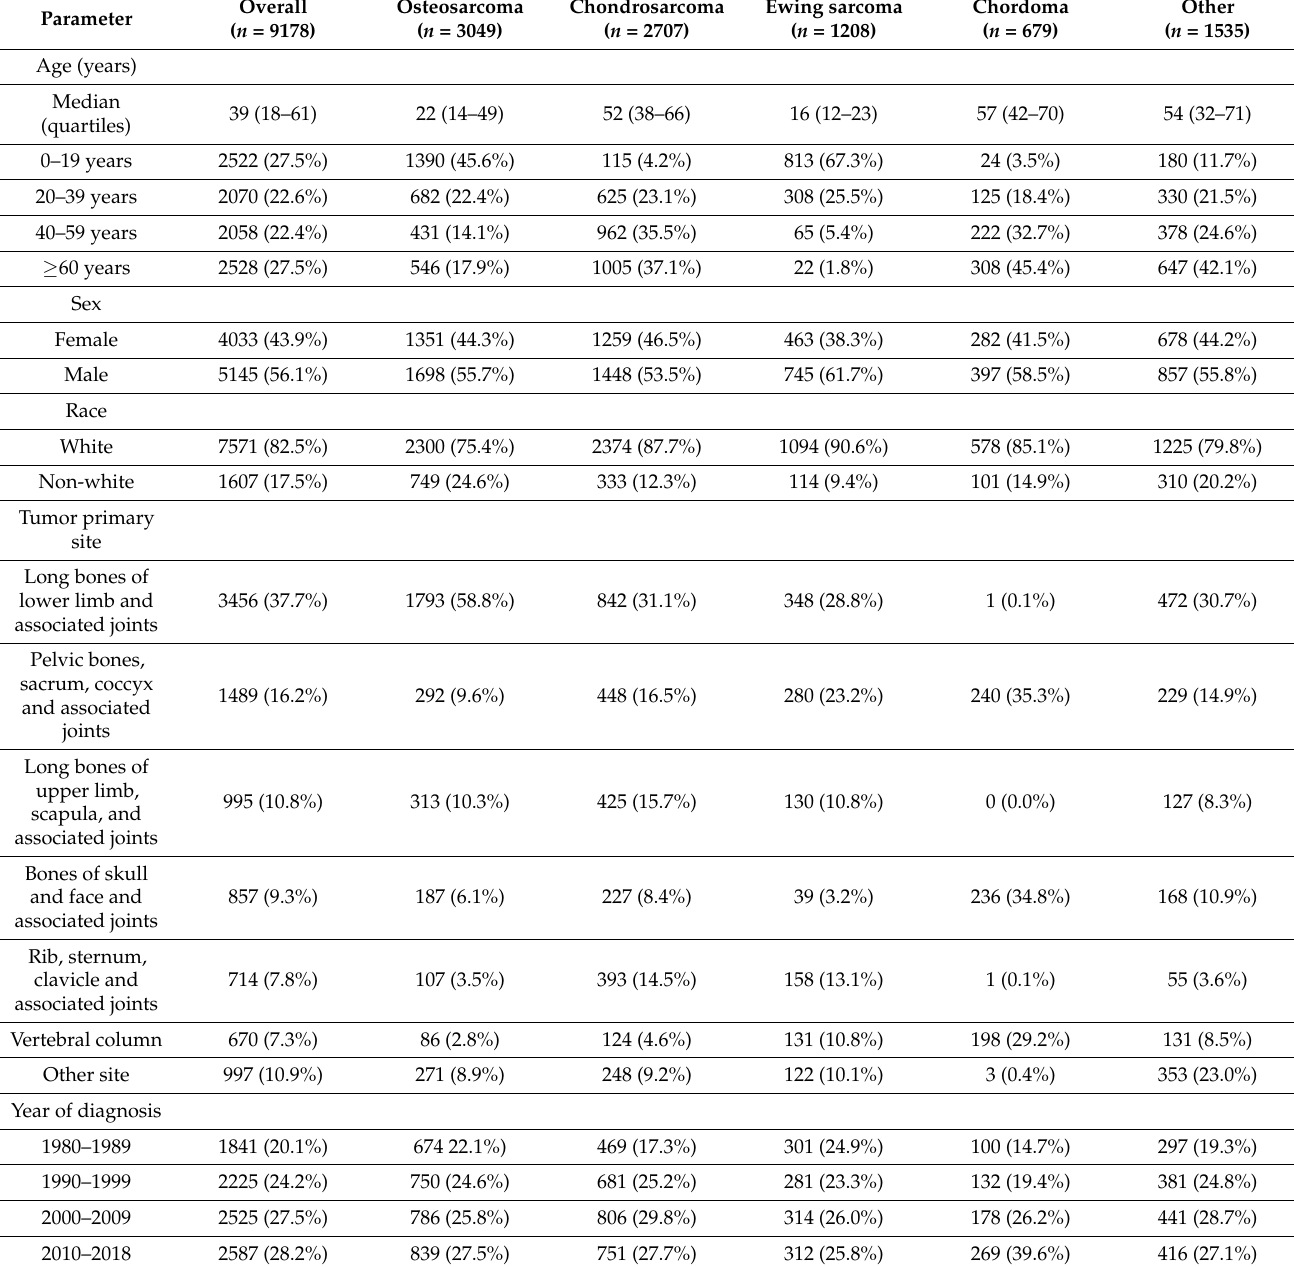
Ewing tumor, 679 (7.4%) were chordoma, and 1535 (16.7%) were other histological types. The median onset ages of osteosarcoma, chondrosarcoma, Ewing tumor, and chordoma were 22, 52, 16, and 57 years, respectively. Ewing tumor patients were more likely to be males (61.7%). Osteosarcoma patients had a higher proportion of non-white patients (24.6%). Different histological sarcomas had different predilection sites. Osteosarcoma and chondrosarcoma usually occur in long bones of lower limb. Ewing sarcoma often occurs in long bones of lower limb and pelvis. Chordoma occurs in pelvis, skull and face bones, and vertebral column. The patient number increased along the four time periods. Patients with different histological sarcomas had similar median household incomes and geographic areas (Supplementary Table S1). Table 1. Demographic and neoplastic characteristics of the patients,